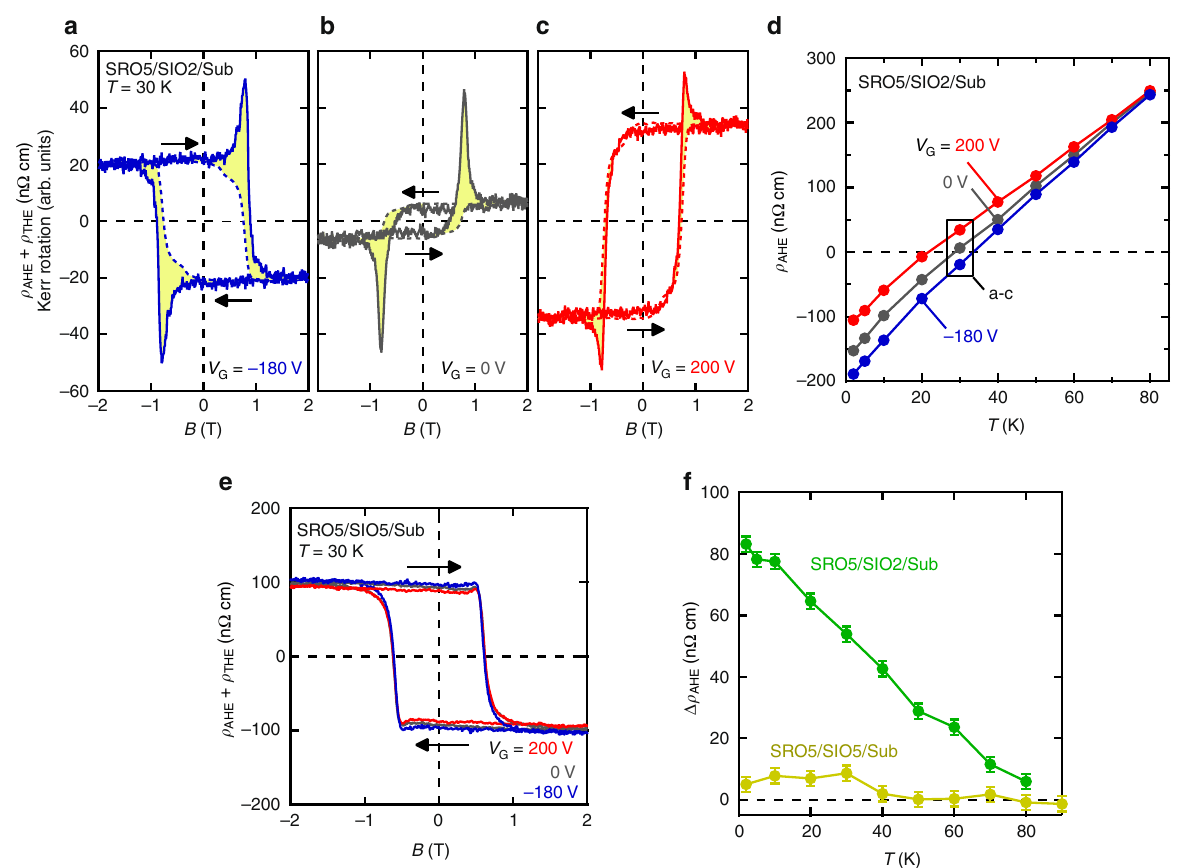
Fig. 2 Electric- fi eld control of anomalous Hall effect. Magnetic- fi eld ( B ) dependence of anomalous and topological Hall resistivities ( ρ AHE + ρ THE , solid lines) at 30 K under gate voltage V G = − 180 V ( a ), 0 V ( b ), and 200 V ( c ) for SRO5/SIO2/Sub. Magneto-optic Kerr rotation as a function of B under the same gate bias is also shown by broken lines in each panel. Yellow colored regions correspond to ρ THE . Black arrows indicate the sweep direction of B . d Temperature ( T ) dependence of ρ AHE under V G = − 180 V (blue), 0 V (gray) and 200 V (red). The black box corresponds to the data in a – c . e B dependence of ρ AHE + ρ THE at 30 K under V G = − 180 V (blue), 0 V (gray), and 200 V (red) for SRO5/SIO5/Sub. f T dependence of variation in anomalous Hall resistivity ( Δ ρ AHE ) between V G = 200 V and V G = − 180 V for SRO5/SIO5/Sub (yellow) and SRO5/SIO2/Sub (green). Error bars include the uncertainty of the sample thickness and of electrical (yellow colored regions in Fig. 2a – c). Figure 3a shows the electric = 0.8 T. The electric fi eld fi eld-controlled peak of ρ THE around B also tunes the range of magnetic fi eld where fi nite ρ THE appears; when the positive (negative) gate voltage is applied, ρ THE gets smaller (larger) and the magnetic fi eld region gets shrunk (enlarged). The variation in peak of ρ THE ( Δ ρ THE = ρ THE ( V G = 200 V) − ρ THE ( V G = − 180 V)) normalized by zero-bias value ( Δ ρ THE / ρ THE (0 V)) is as large as 55%. The sign of THE remains the same during the sign inversion of AHE by electric fi eld, supporting that the origins of AHE and THE are clearly distinct from each other as previously indicated 12 .